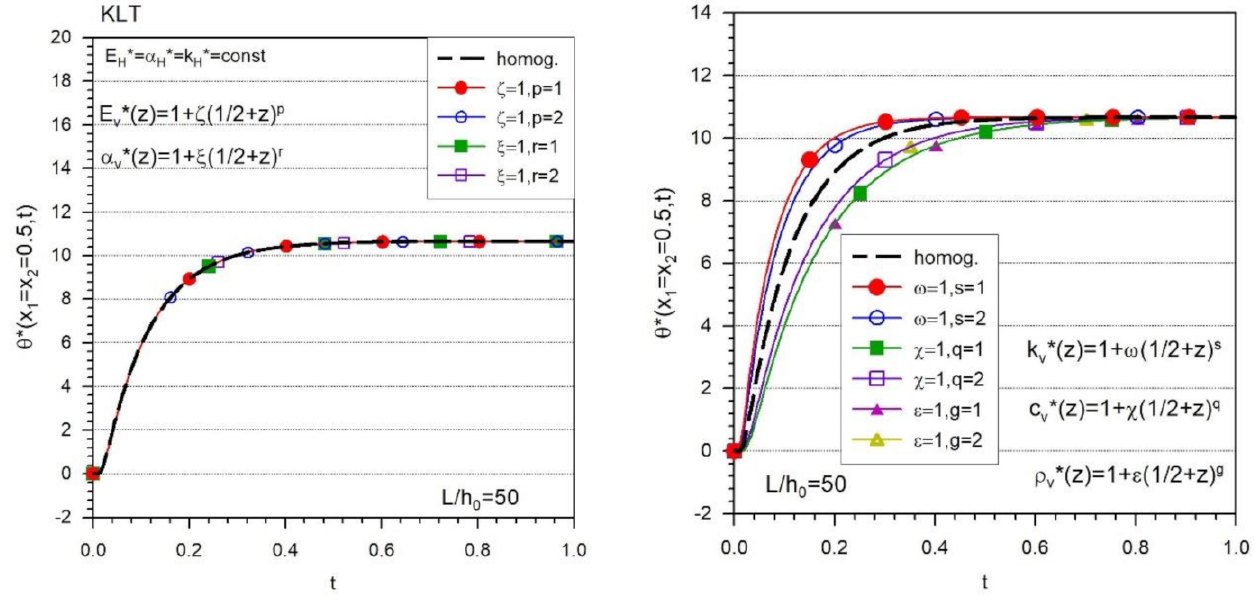
Figure 11. Time variation of the temperature in the homogeneous as well as FGM